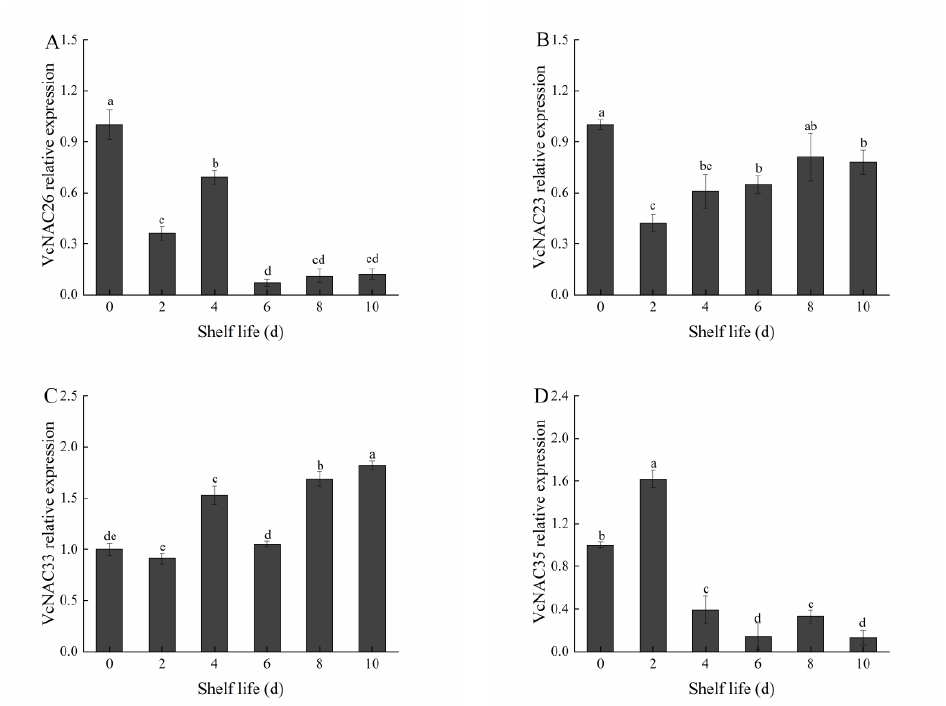
Figure 12. Heatmap analysis of the expression of 28 transcription factors in blueberry fruit.